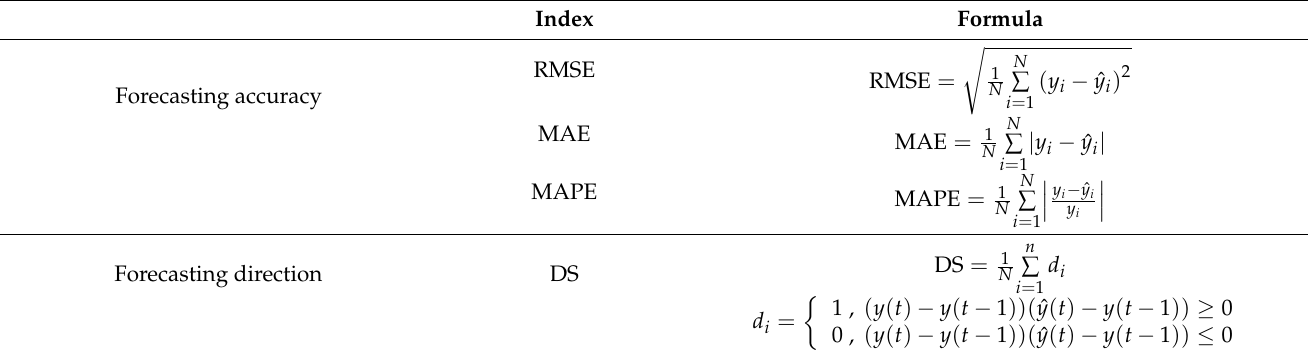
Table 2. Evaluation criteria for the proposed model for forecasting the price of